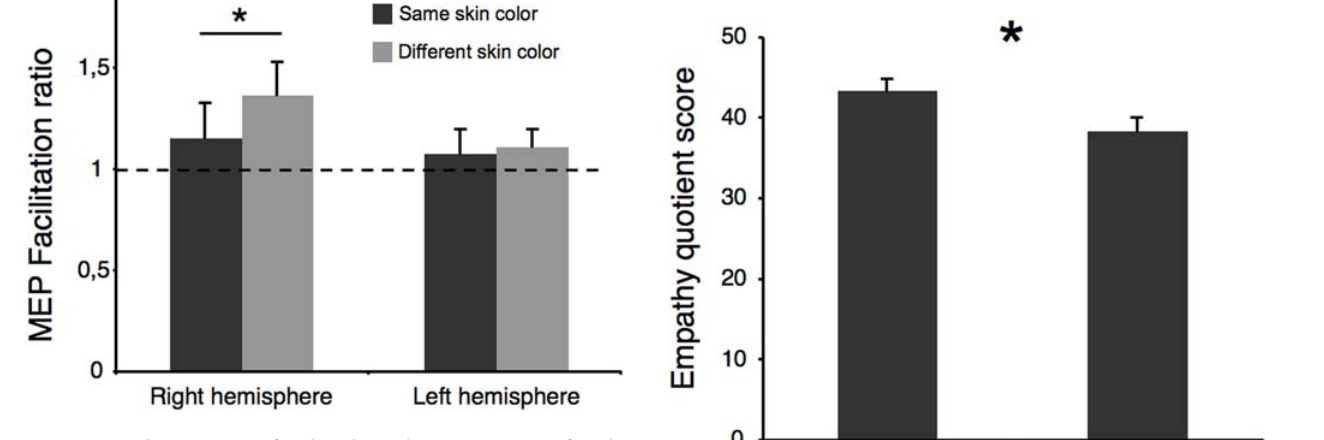
Figure 3. Facilitation ratios for the skincolorcomparison in female participants. In the right hemisphere, observing hand movements performed by a hand of a different color from that of the participant produces more motor cortex facilitation than observation of a hand of similar color.